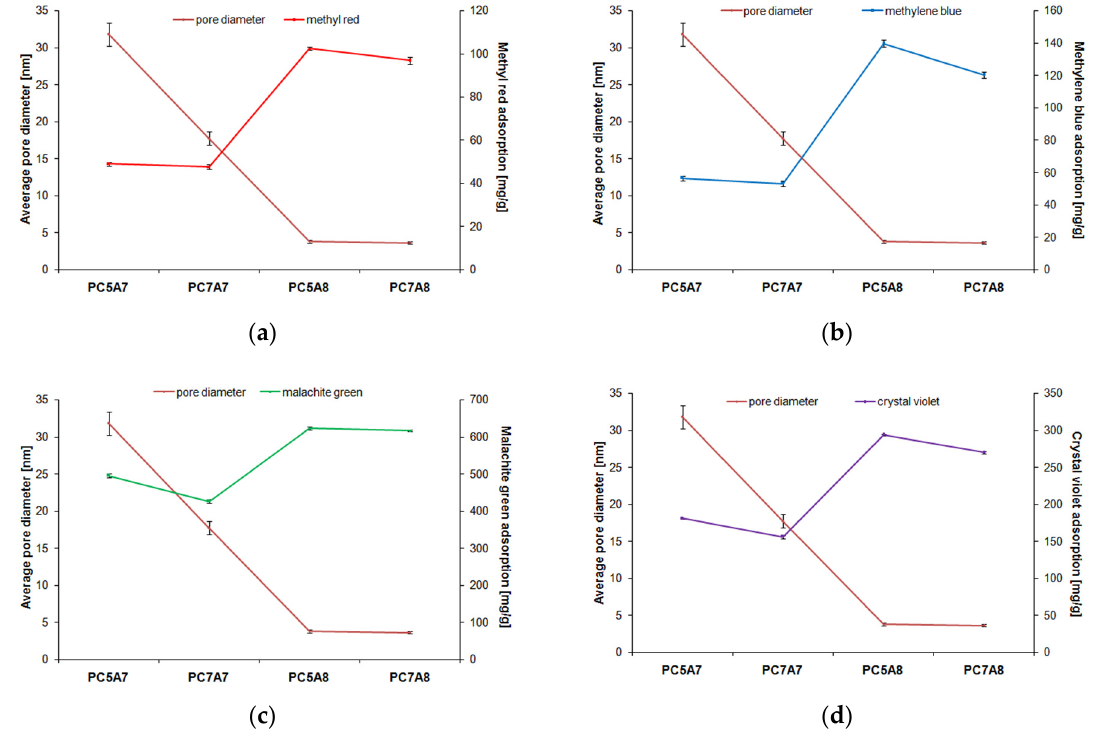
Figure 11. Dependence of the carbon adsorbents adsorption capacity on their average pore diameter for adsorption of: ( a ) methyl red, ( b ) methylene blue, ( c ) malachite green, ( d ) crystal violet.